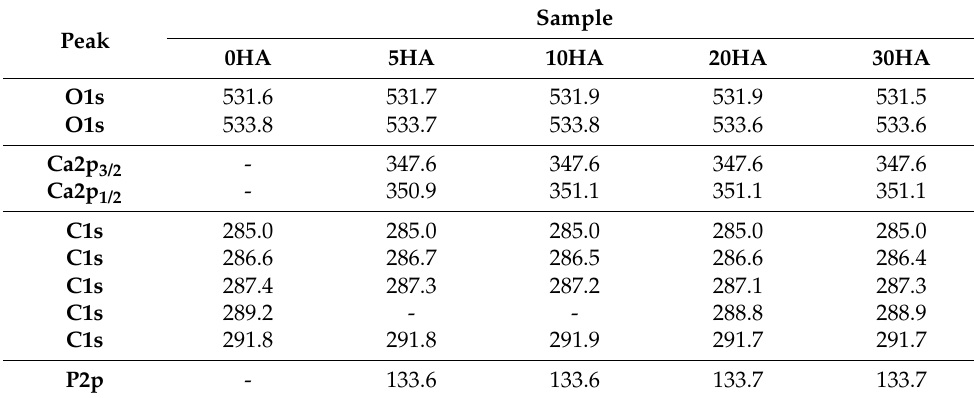
Table 2. XPS peak positions from peak fitting.